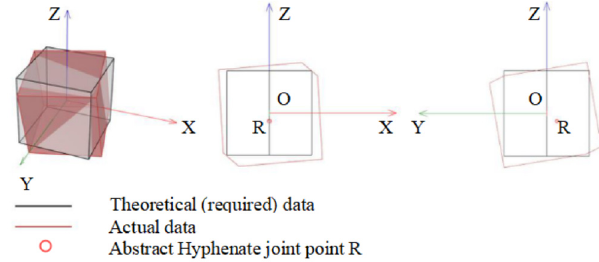
Fig. 13. Three-dimensional deviation and its